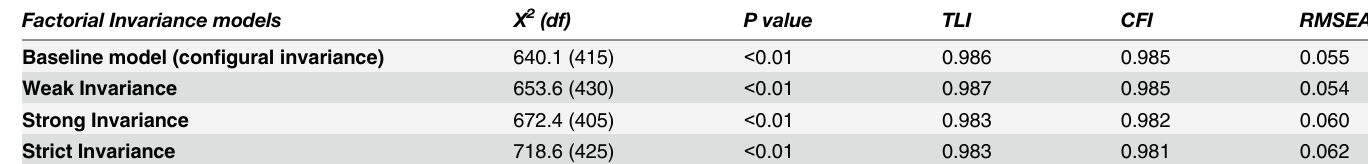
Table 4. Model fit indices of the multigroup models for factorial invariance testing across THA and TKA.